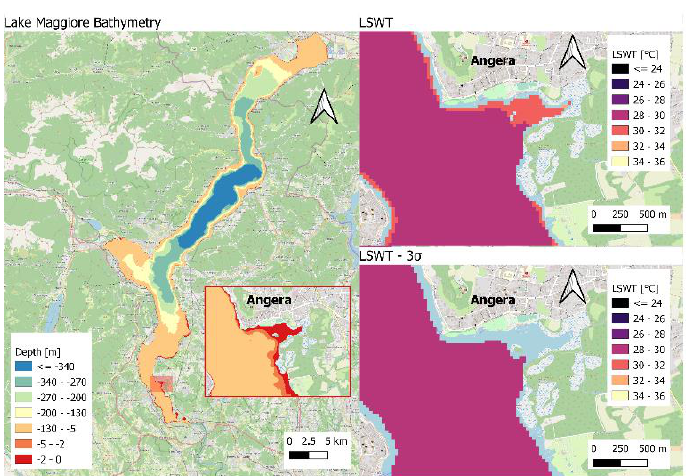
Figure 4 . Maggiore lake bathymetry (on the left) and SIMILE WQP LSWT map of 20 th August 2020 before (top right) and after (bottom right) the 3  outlier rejection.